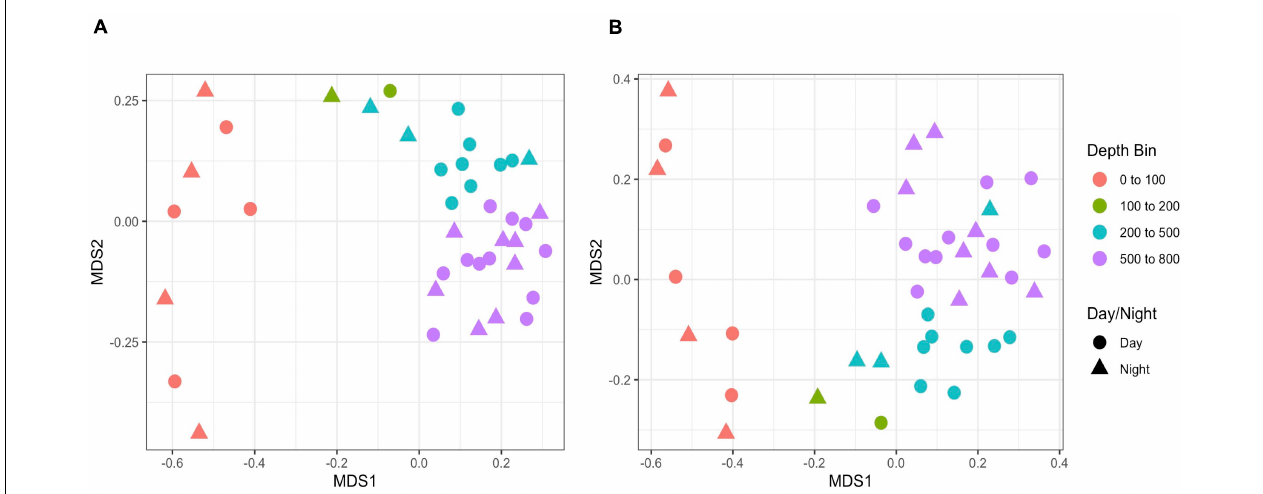
FIGURE 8 | NMDS plots of eDNA data based on (A) Jaccard and (B) Bray-Curtis indices. Bray-Curtis indices are based on log-transformed data. Shapes indicate day vs. night sampling and color indicates depth